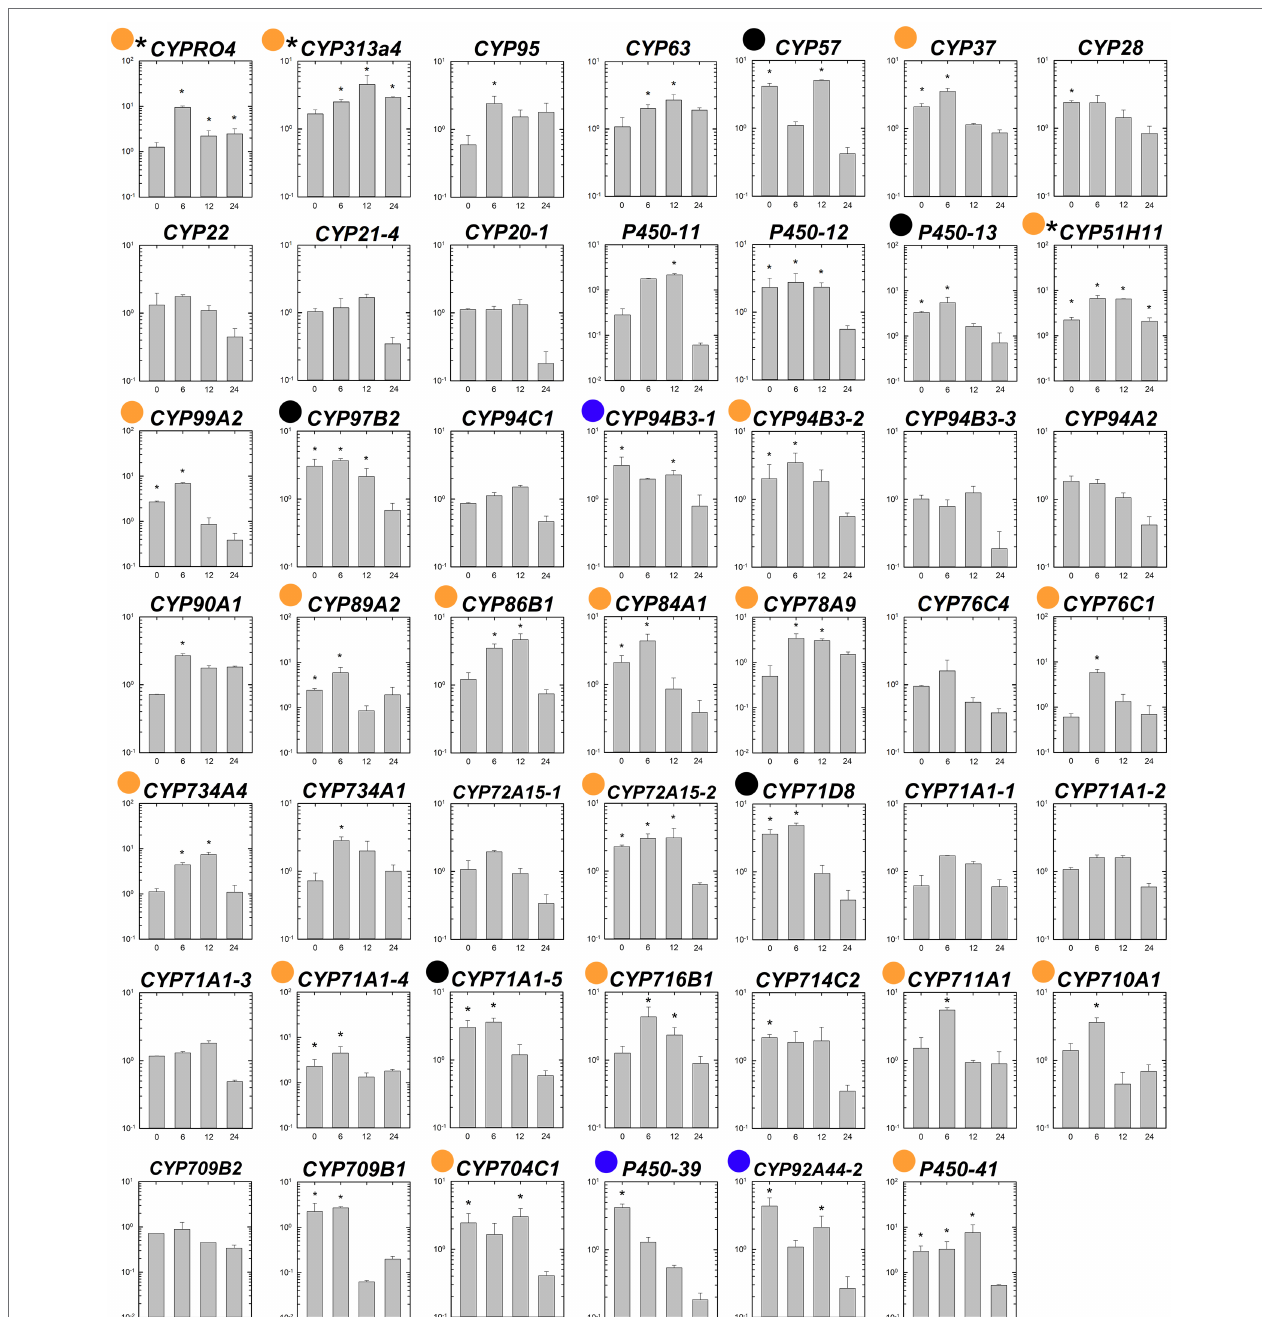
FIGURE 5 | Comparison of relative expression levels of each putative P450 gene in the S and R lines of Polypogon fugax before and after fenoxaprop- P -ethyl treatment. The X -axis represents the time (h) after fenoxaprop- P -ethyl treatment, and the Y -axis represents the ratio of relative transcript levels in the R line relative to that in the S line at each sampling time point. Data are the mean values ± SEM. Blue dots marked genes were constitutively up-regulated more than threefold in the R than in the S line, orange dots marked genes were fenoxaprop- P -ethyl-induced up-regulated more than threefold in the R than in the S line for at least one time point, and black dots marked genes were both constitutively and herbicide-induced up-regulated more than threefold in the R than in the S line. Asterisk marked genes were constantly up-regulated in the R than in the S line during 6–24 h after treatment. *Foldchange ≥ 2 and p <